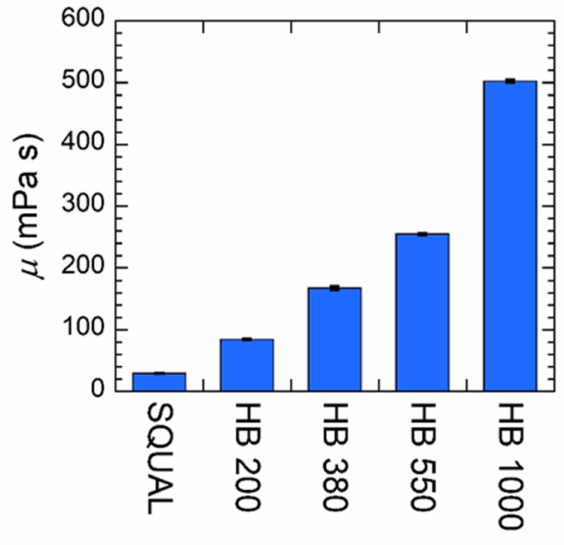
Figure 1. Dynamic viscosity values for various gel solvents used in this study; SQUAL = squalane, HB 200 = Hydrobrite 200, HB 380 = Hydrobrite 380, HB 550 = Hydrobrite 550, and HB 1000 = Hydrobrite